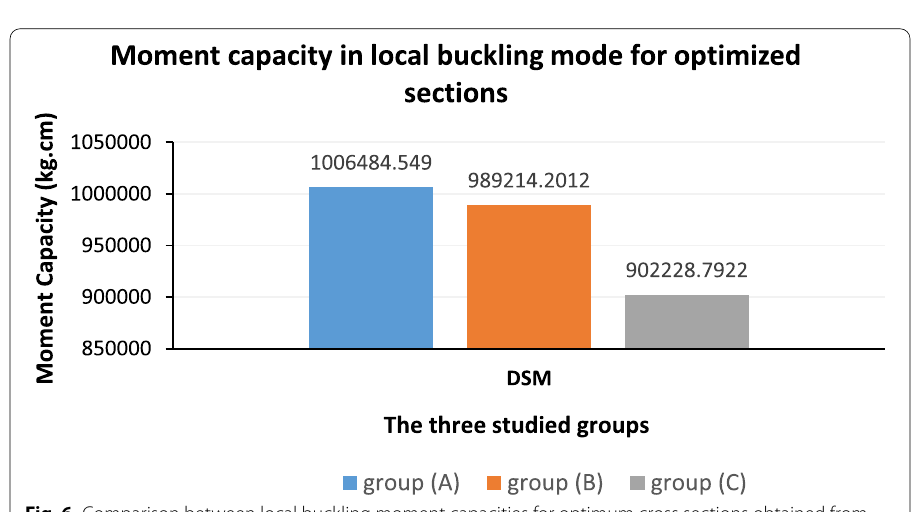
Fig. 6 Comparison between local buckling moment capacities for optimum cross sections obtained from PSO using